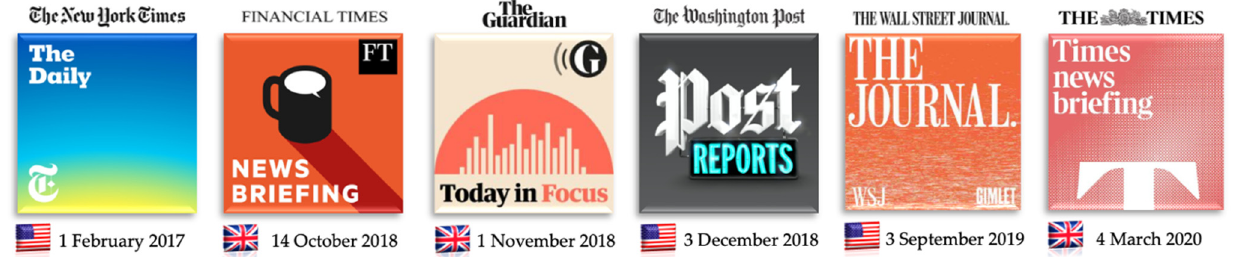
Figure 1. Daily podcasts produced currently by the most important newspapers in the USA and UK.